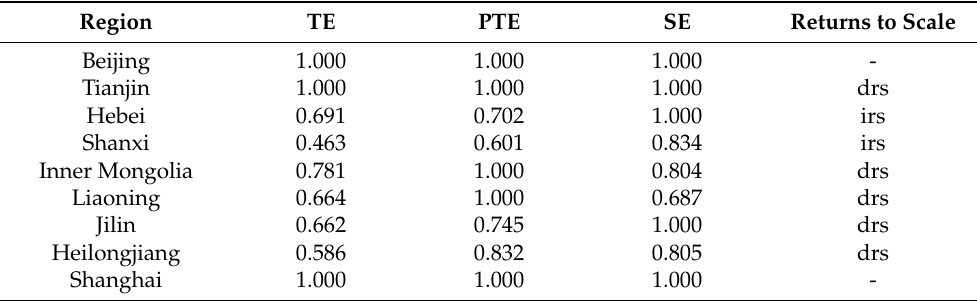
Table A2. The adjusted technical efficiency and scale efficiency of provincial public sports service